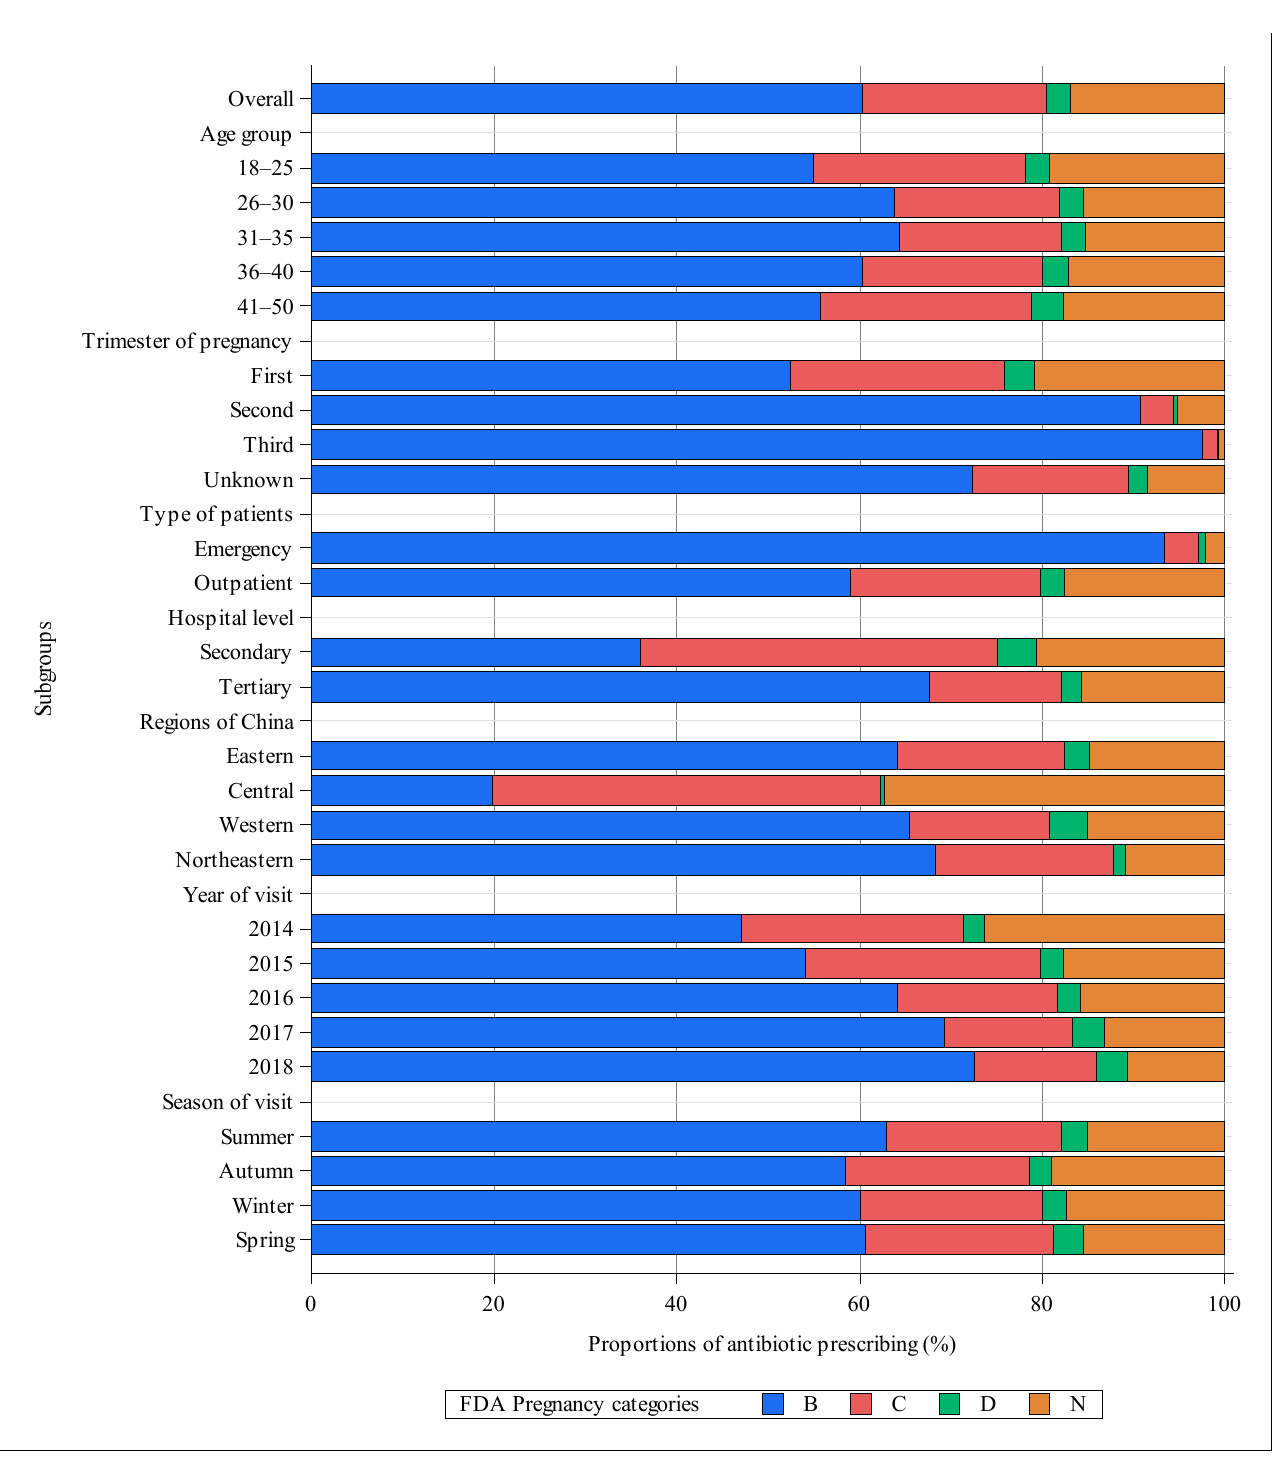
Figure 1. Proportions of antibiotics of FDA pregnancy categories within different subgroups. Category N is not a FDA pregnancy category. In this study, category N referred to antibiotics that had not been assigned any FDA category.